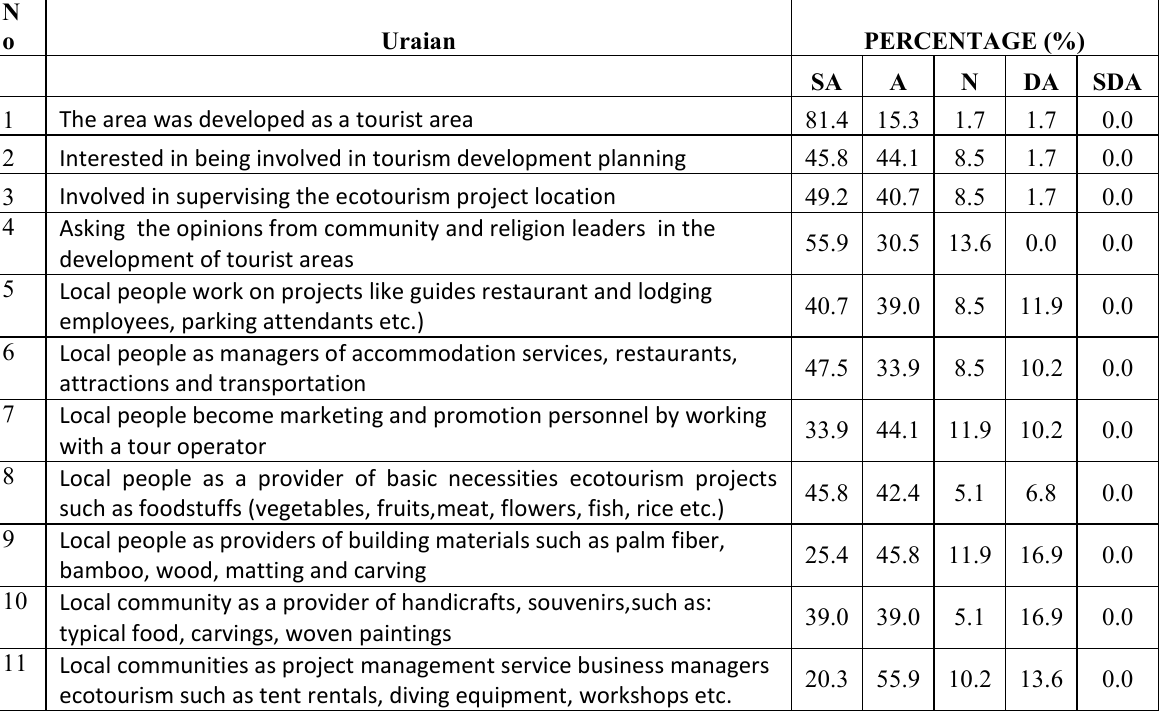
Table 2 Local Community's Perception of Ecotourism